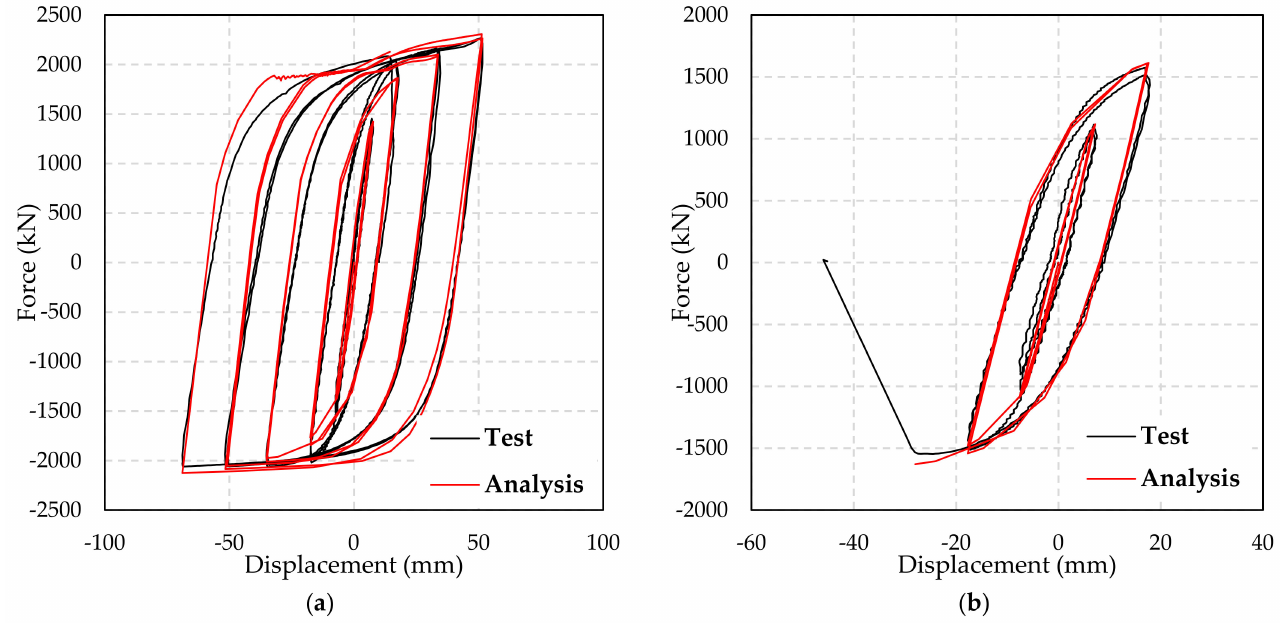
Figure 14. Comparison of finite element and results: ( a ) C216 t8–C267 t6-B3 ; ( b ) S125 t9–S200 t9-B .